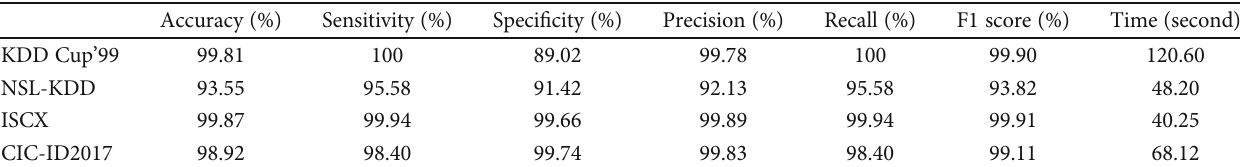
Table 11: Testing results of LSTM-RNN algorithm.